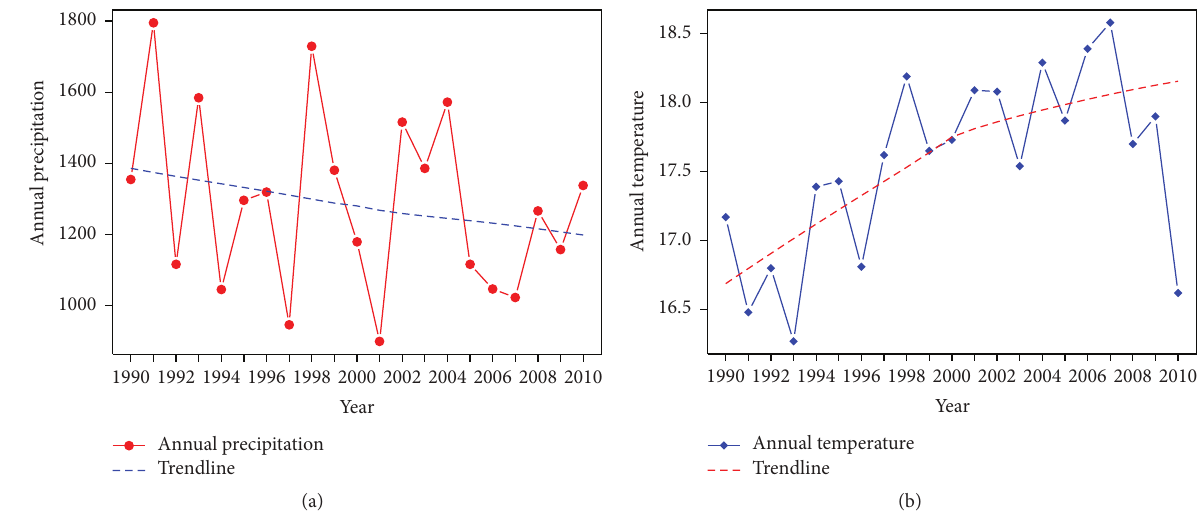
Figure 7: (a) The graphs of annual precipitation. (b) The graphs of annual temperature.